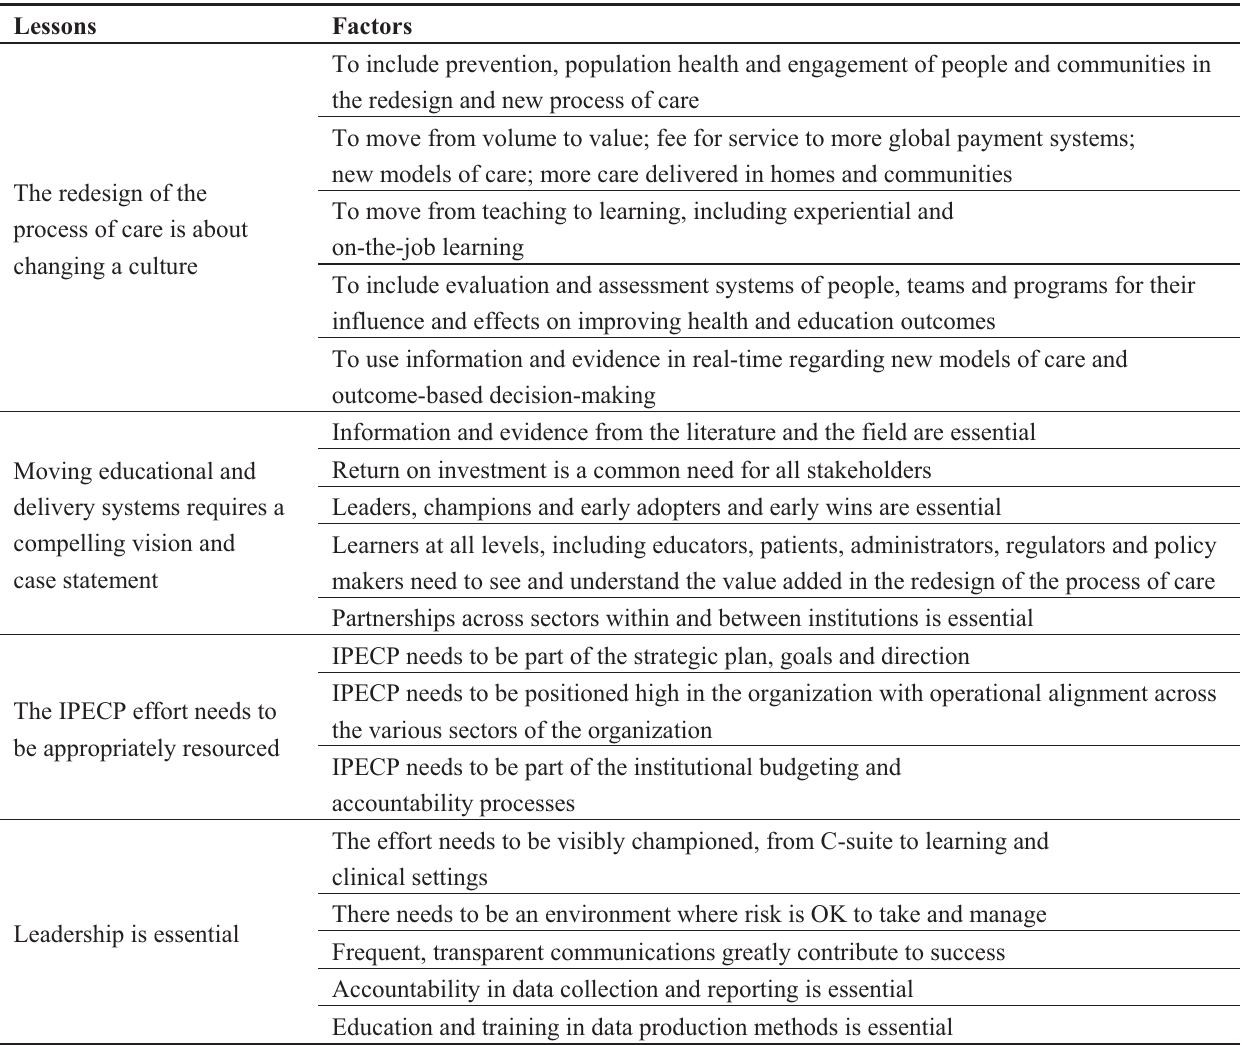
Table 3. Preliminary lessons and success factors from the nexus innovation network for IPECP linked to outcome